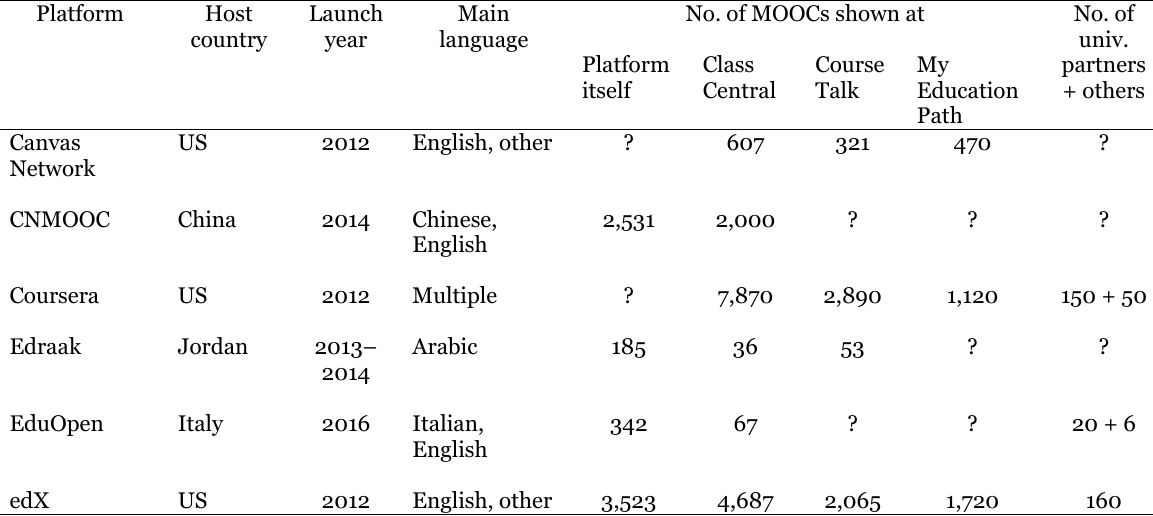
MOOC Platforms: Demographics and